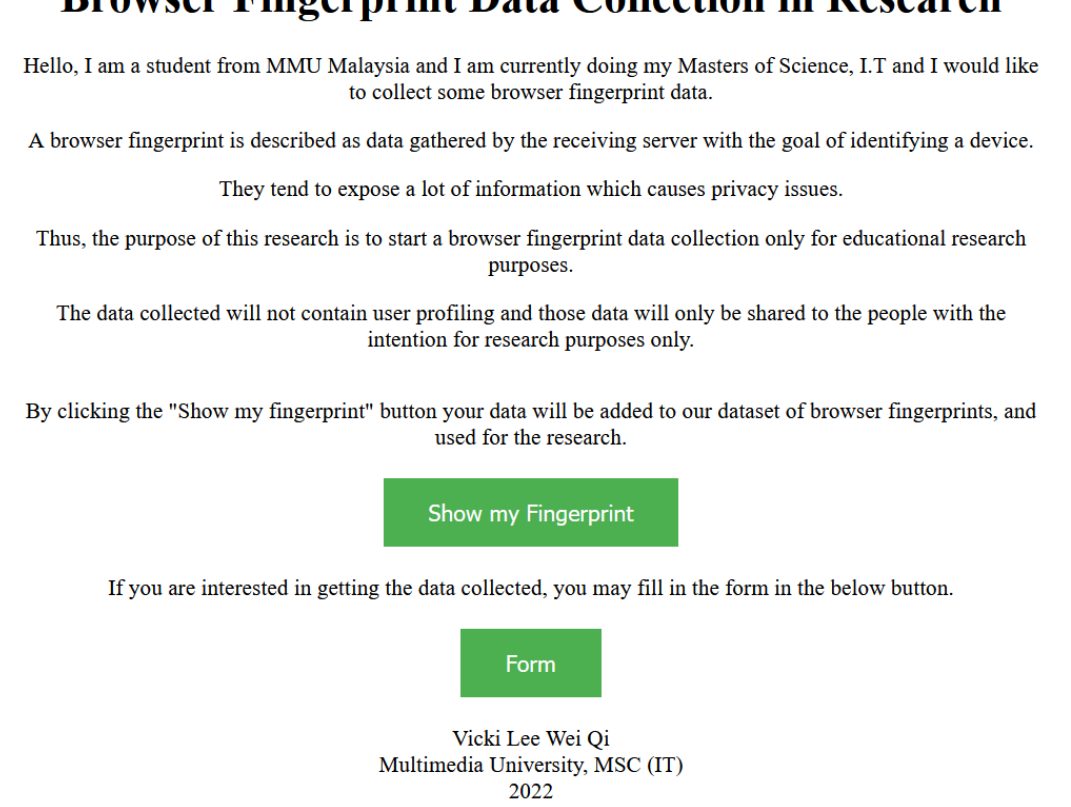
Figure 1. Snapshot of the first page of the designated website.